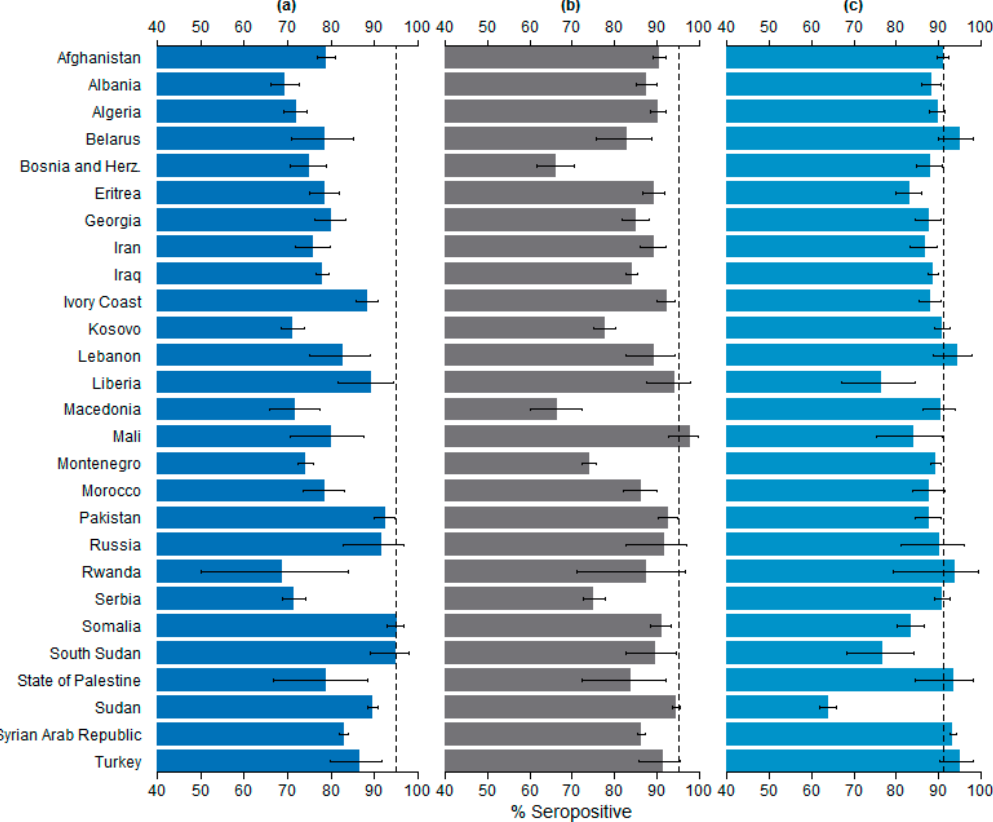
Figure 1. Seroprevalence by country of origin with 95% confidence intervals: ( a ) Measles; ( b ) Rubella; ( c ) Varicella. The dotted lines mark the herd immunity thresholds (95% for measles and rubella, 91% for varicella [8–11]).